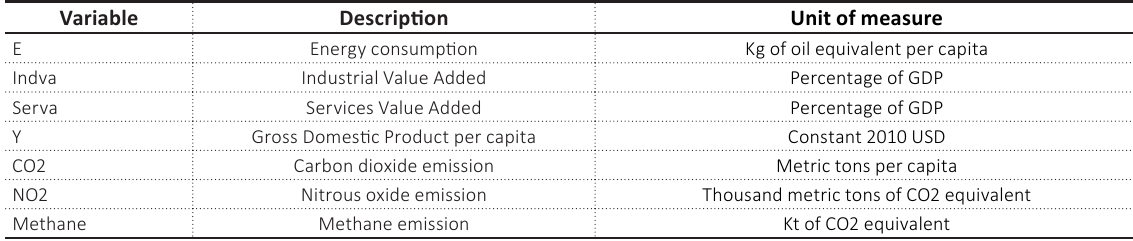
Table 1. Variables and units of